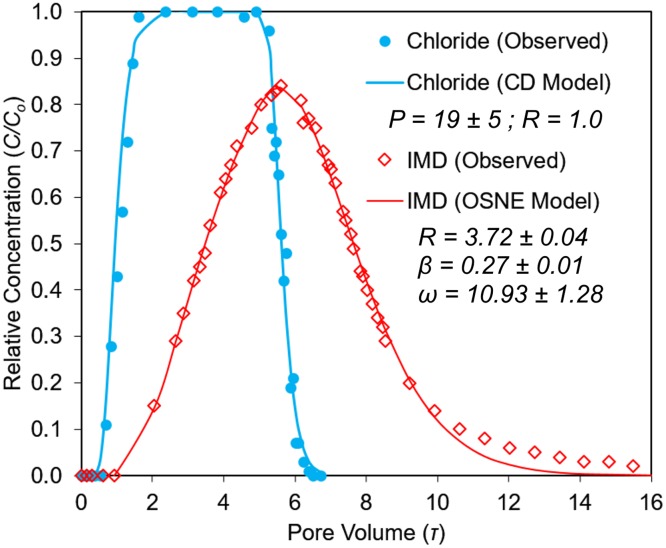
Imidacloprid (IMD) and tracer (Cl-) BTC from the A-horizon column and corresponding transport parameters.Solid lines indicate the optimized transport models (CD and OSNE).